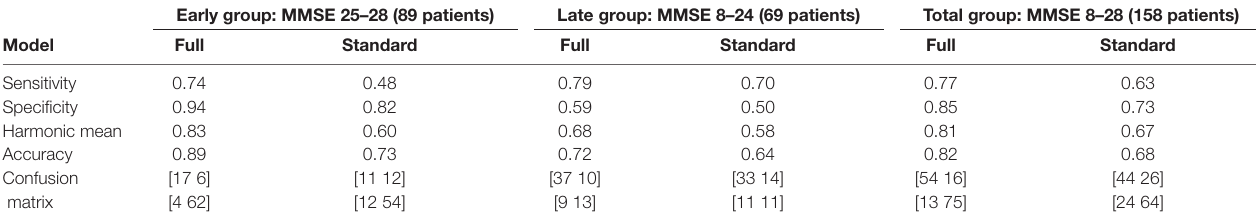
TABLE 3 | Sensitivity, specificity, their harmonic mean and accuracy of predicting AD (according to TB ratio) for the three MMSE groups and the two models (full model with and standard model without newly developed